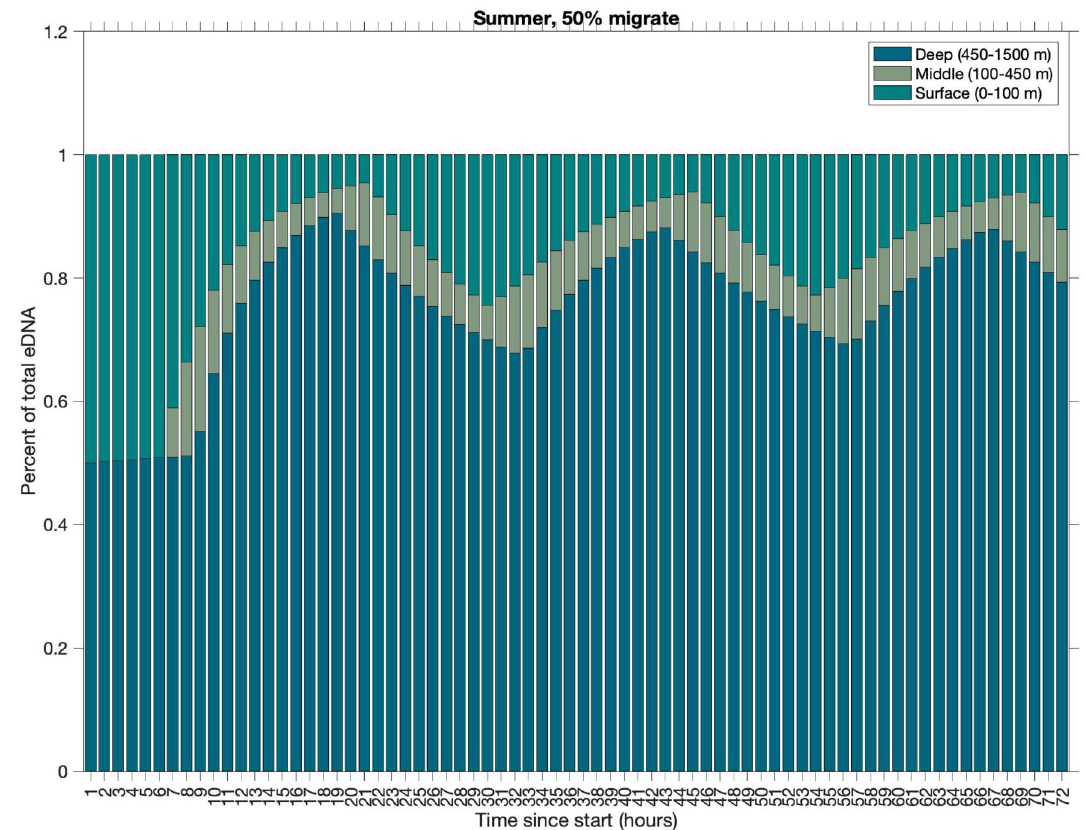
Figure 4. Temporal evolution of the proportion of eDNA concentration binned by depth category in a representative simulation. Here, the first three days (72 h) of a summer (JAS) simulation with 50% of individuals migrating is shown. The proportion of eDNA is shown in three depth bins at each time point: surface (0–100 m), mid-depth (100–450 m) and deep water (450–550 m). The DVM-induced temporal variation of the relative proportion and the persistence of eDNA in the surface layer when organisms are not present in the daytime are